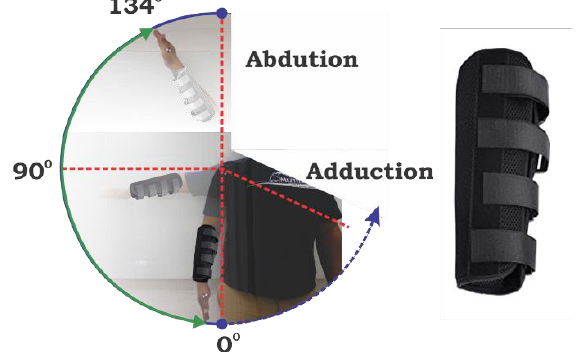
Figure 22. Elbow splint immobilizer.